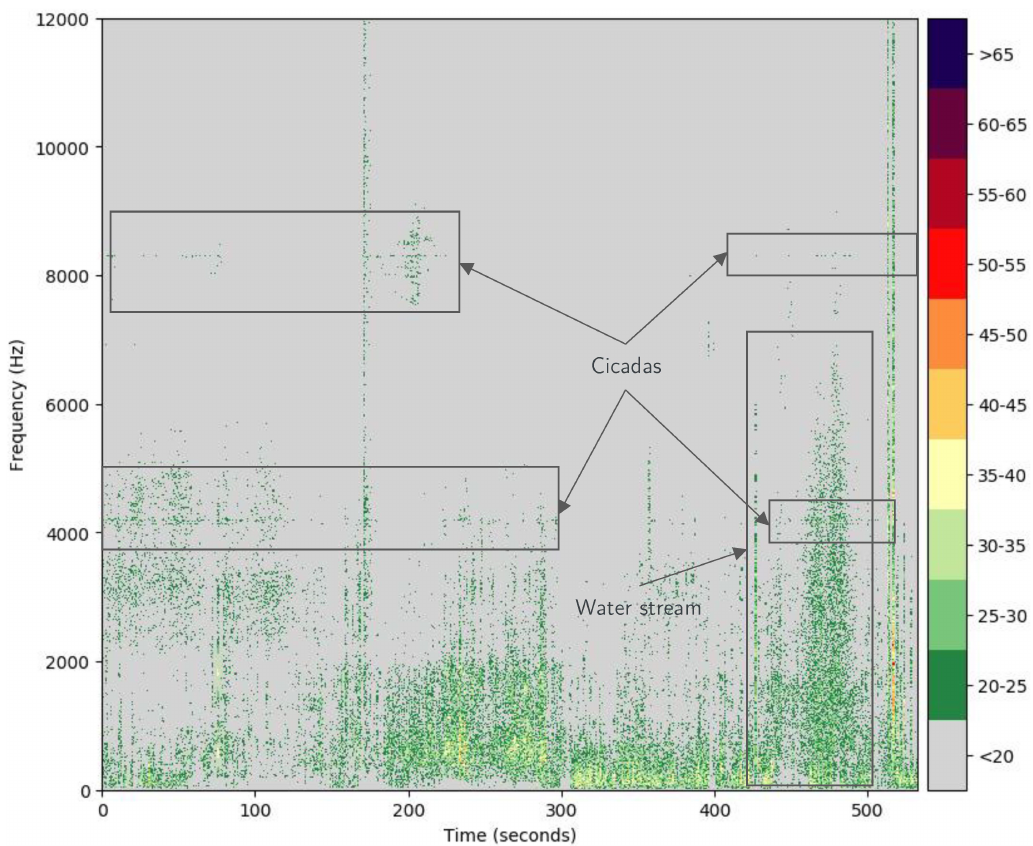
Figure 10: Spectrogram of the soundscape from starting of the torii gates to